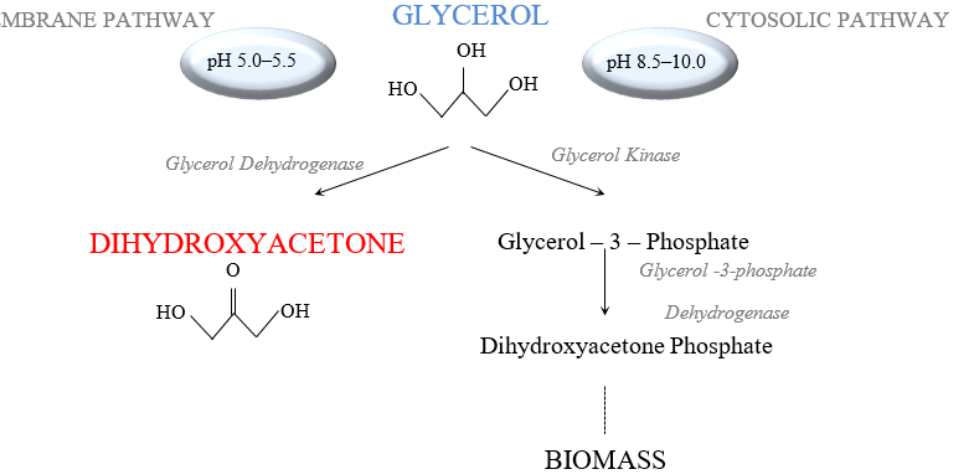
Figure 1. A scheme of two pathways of g l ycerol metabolism in bacteria cells depending on pH